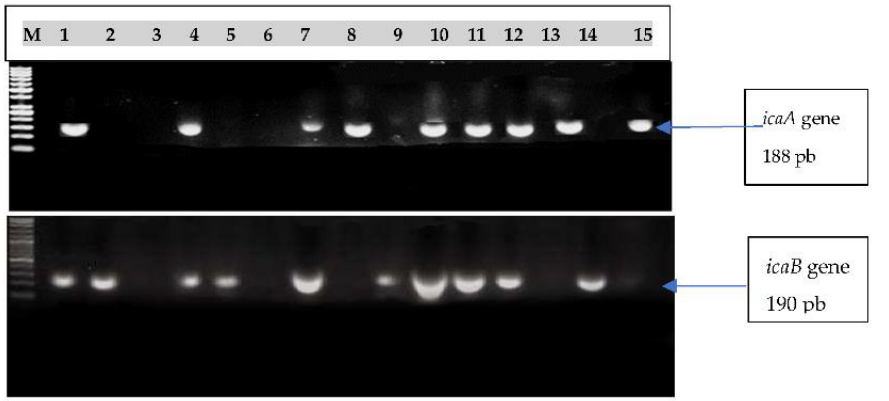
Figure 1. Electrophoretic pattern of Multiplex PCR amplicons of icaA gene and icaB gene on agarose gel in 15 samples of the 30 investigated staphylococci isolates (Table 4). Lane M was a 50 bp DNA